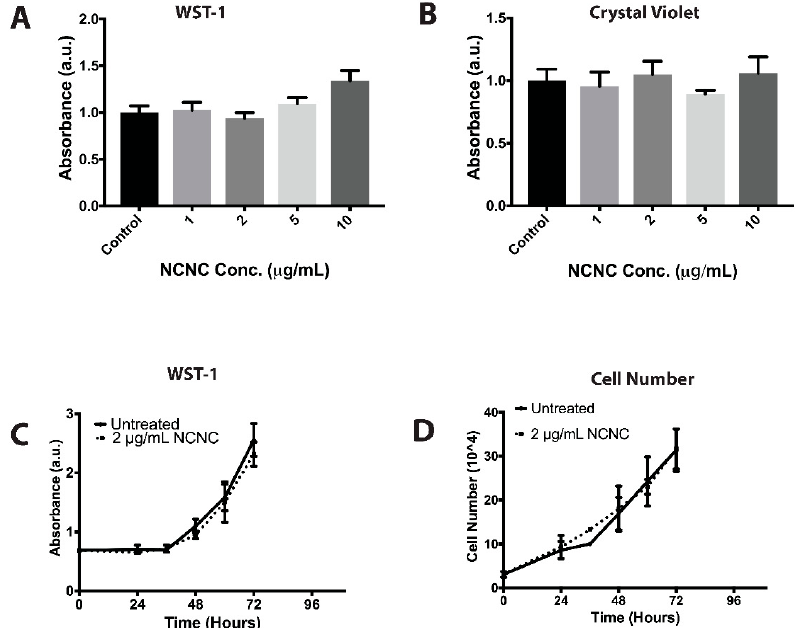
Figure 1. Metabolic and proliferation assays on HeLa cells treated with nitrogen-doped carbon nanocups (NCNCs). ( A ) HeLa cells were treated with increasing concentrations of NCNC for a duration of 24 h. After incubation, cells were assayed for metabolic activity using a WST-1 assay, n = 3 readings for each concentration. ( B ) HeLa cells were treated with increasing concentrations of NCNCs for a duration of 24 h. After incubation cells were assayed for viability using a crystal violet assay, n = 4 readings for each concentration. ( C ) HeLa cells were treated with 2 µ g / mL NCNC over a span of 84 h. Cells were assayed with WST-1 at 12-h intervals, n = 3 readings for each time point. ( D ) Cell number was calculated on HeLa cells treated with 2 µ g / mL NCNC over a span of 84 h using a hemocytometer, n = 2 counts for each time point.